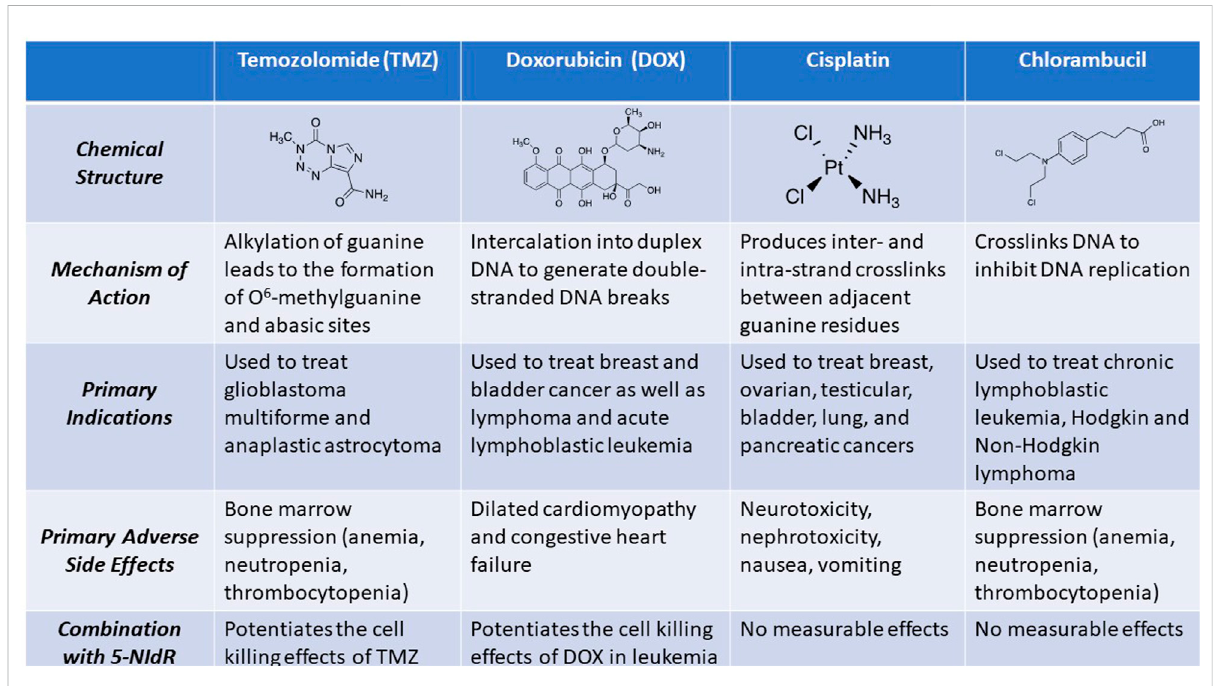
FIGURE 11 Structures and associated activities of representative anti-cancer agents that primarily function as DNA damaging